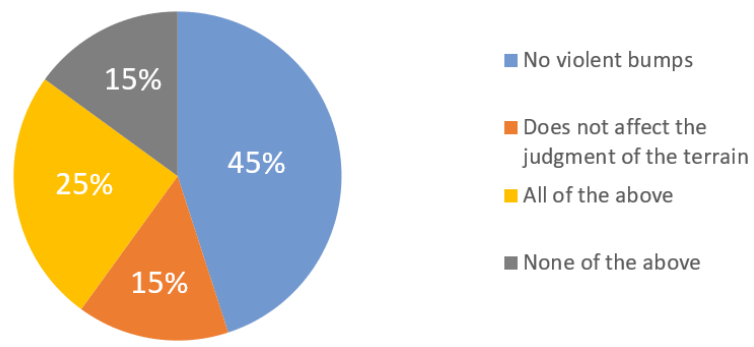
Figure 19. R esults of the questionnaire. Figure 19. Results of the